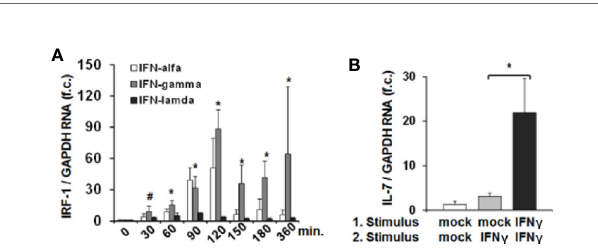
FIGURE 3 | Interferon-response factor-1 (IRF1) transcription exaggerates interferon (IFN)-induced interleukin-7 (IL-7) expression. (A) Quanti fi cation of IRF-1 mRNA levels relative to housekeeping GAPDH mRNA in Huh-7.5 cells, which were treated for the indicated time points with IFN- a (500 i.E./ml), IFN- g (5 ng/ml), or IFN- l 2 (50 ng/ml). IRF-1 mRNA levels relative to housekeeping GAPDH mRNA are expressed relative to untreated cells. Standard deviations of three experiments (n=3) performed with three replicates each are shown. * P < 0.05 and # P <0.1 for comparison of IFN-gamma treatment at the indicated time points versus baseline (i.e. mock), gray bars. Changes for IFN-alfa and IFN-lambda treatment are not signi fi cant. f.c., fold change. (B) Analysis of IL-7 mRNA levels relative to housekeeping GAPDH mRNA in Huh-7.5 cells, which were treated with PBS or one or two doses (baseline and after 6 h stimulation) of 5 ng/ml IFN- g for 24 h. Standard deviations of two experiments (n=2) performed with three replicates each are shown. * P < 0.05 for indicated comparison. f.c., fold change.